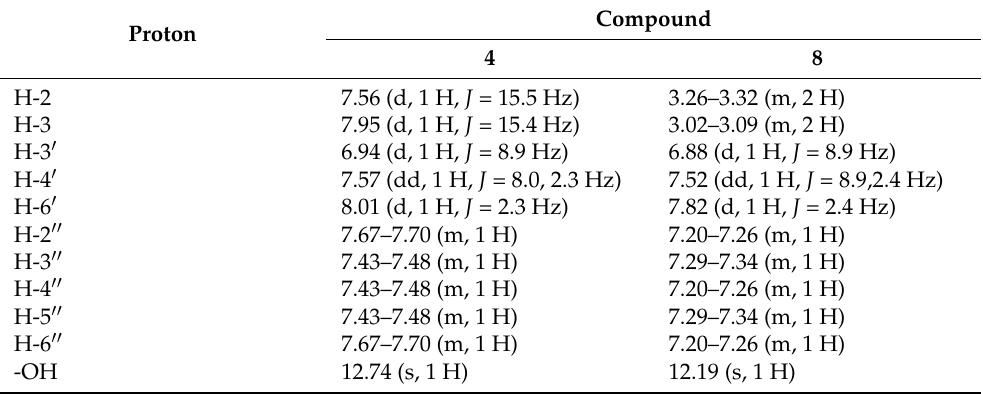
Table 7. Summary of signals visible in the 1 H NMR spectrum of the substrate ( 4 ) and the biotransfor- mation product ( 8